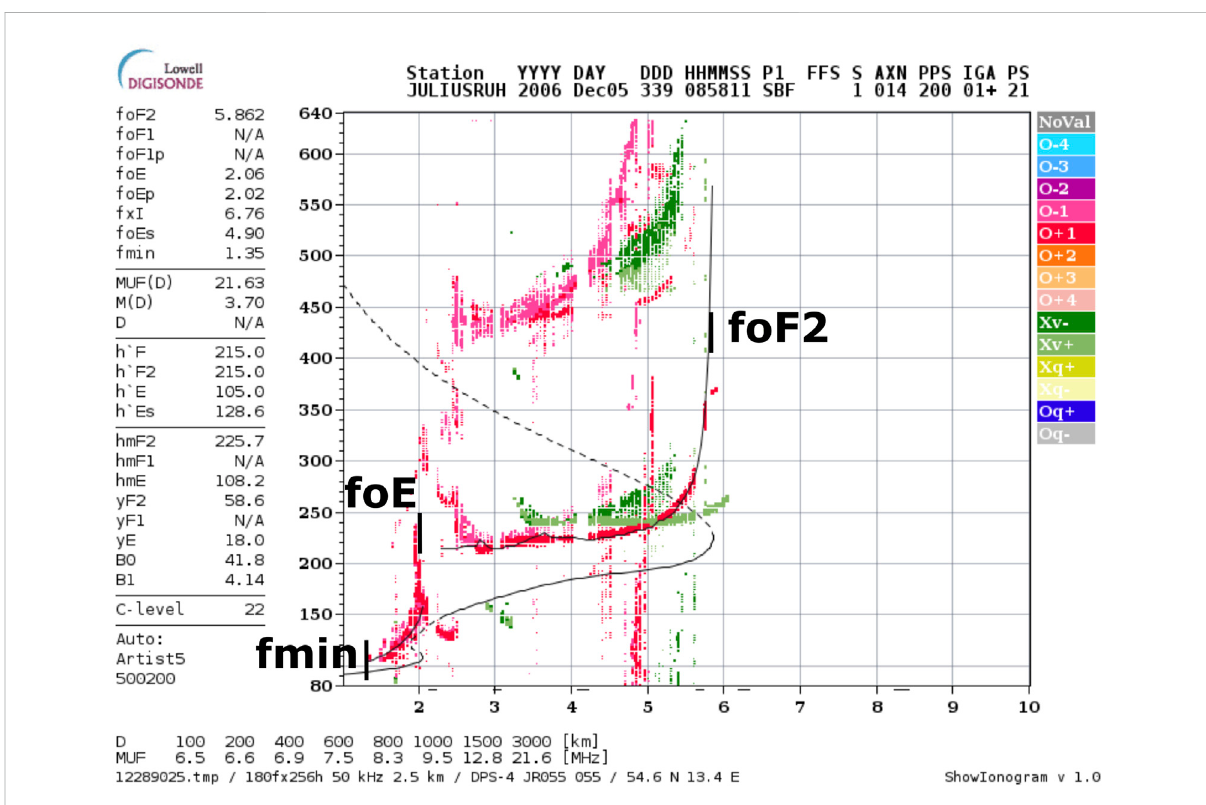
FIGURE 1 AsampleofanionogrammeasuredatJuliusruhat8:58UTon05December2006.Theionosphericparameters(fmin,foEandfoF2)usedduring the investigation are indicated by black lines on the